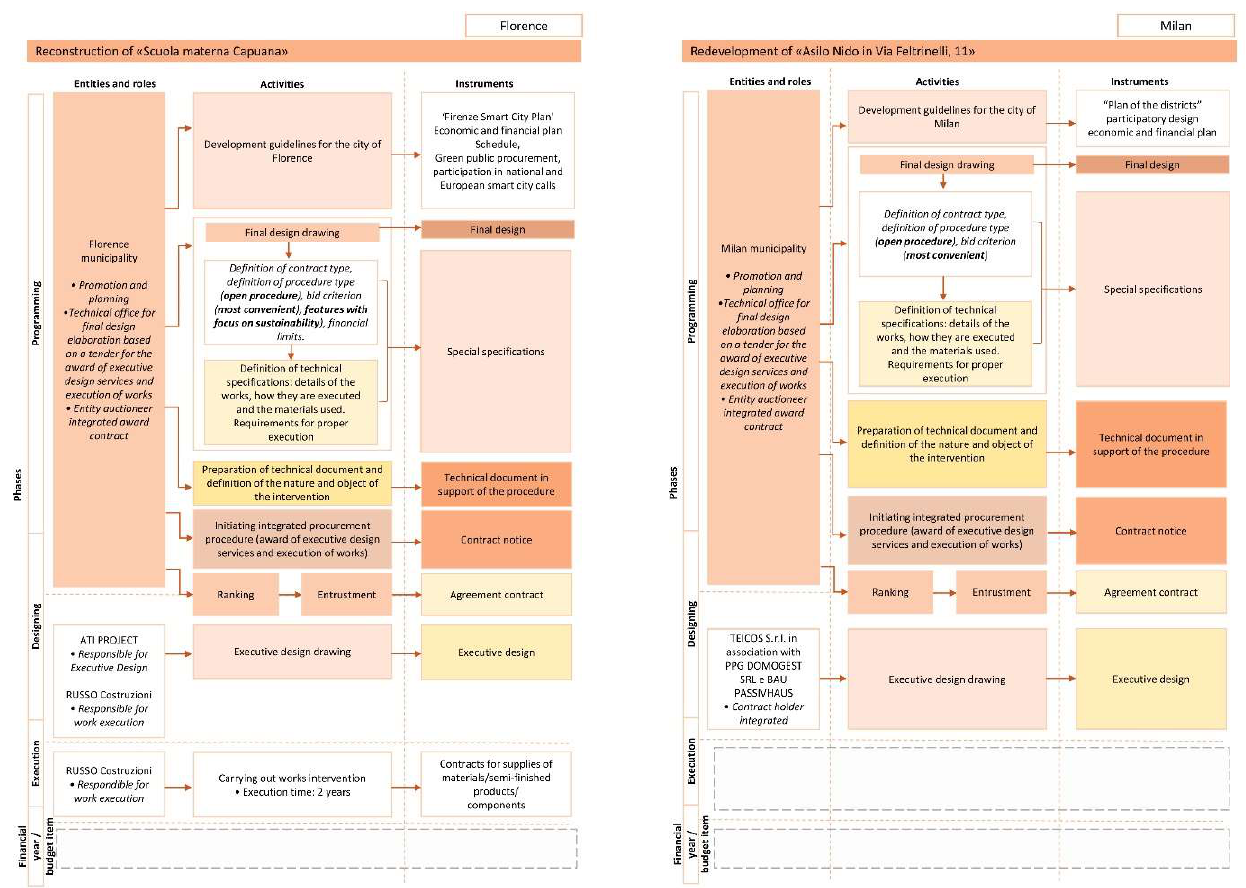
Figure 6. Milan and Florence case study: comparative analysis of the implementation processes.